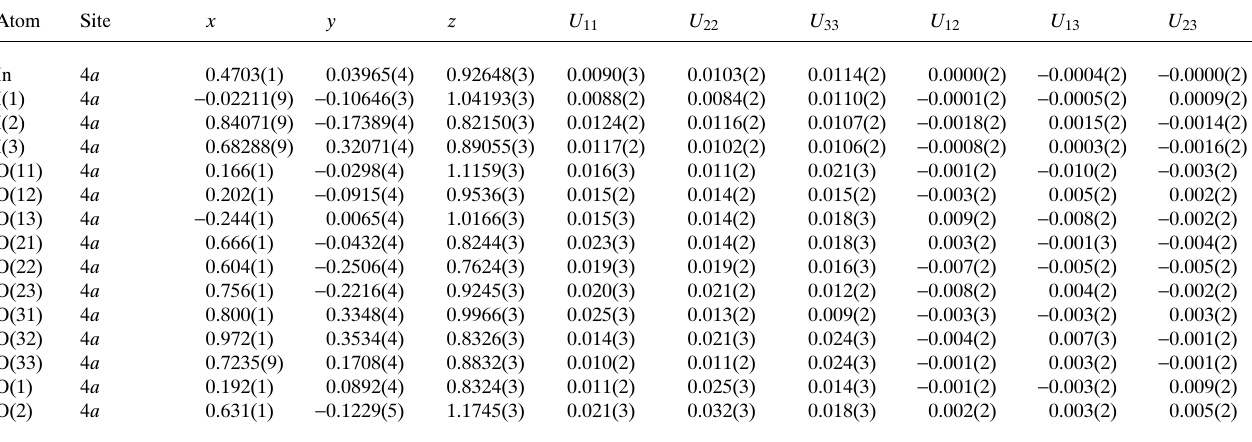
Table 2. Atomic coordinates and displacement parameters (in Å 2 )